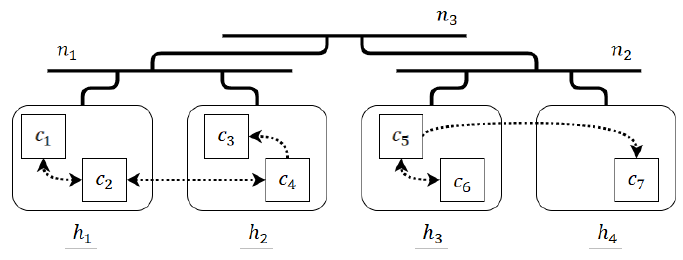
Figure 1. An example of the component deployment problem. The hardware